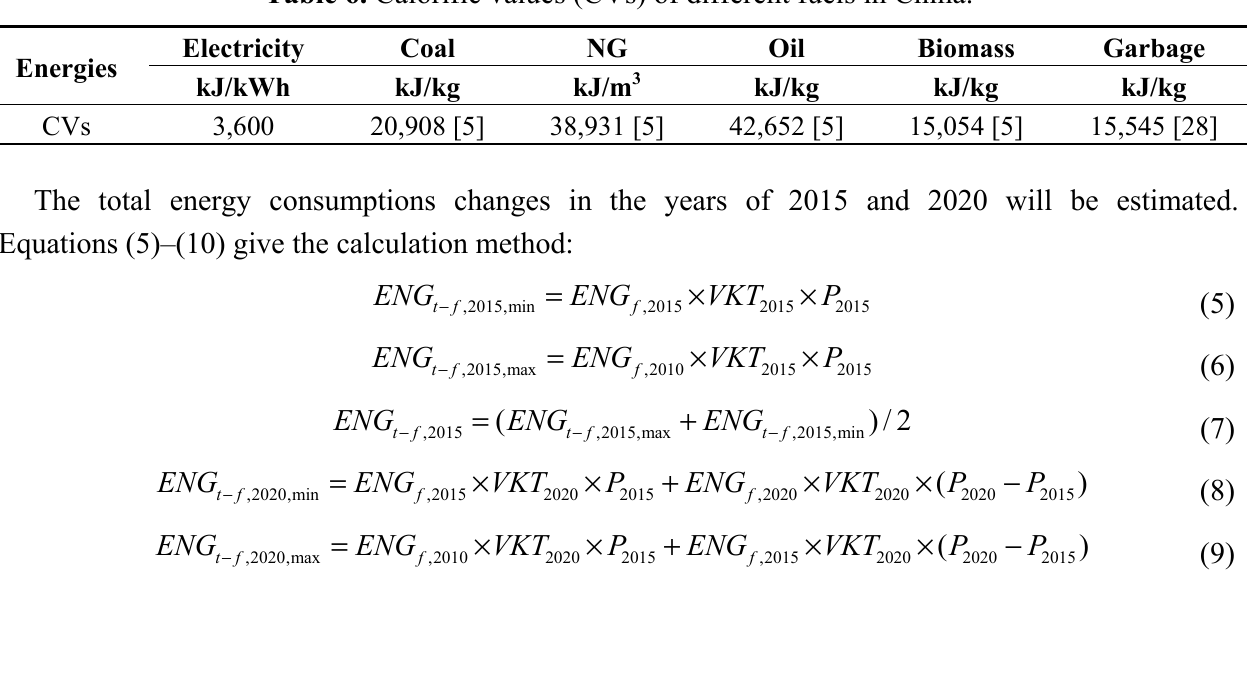
Table 6. Calorific values (CVs) of different fuels in